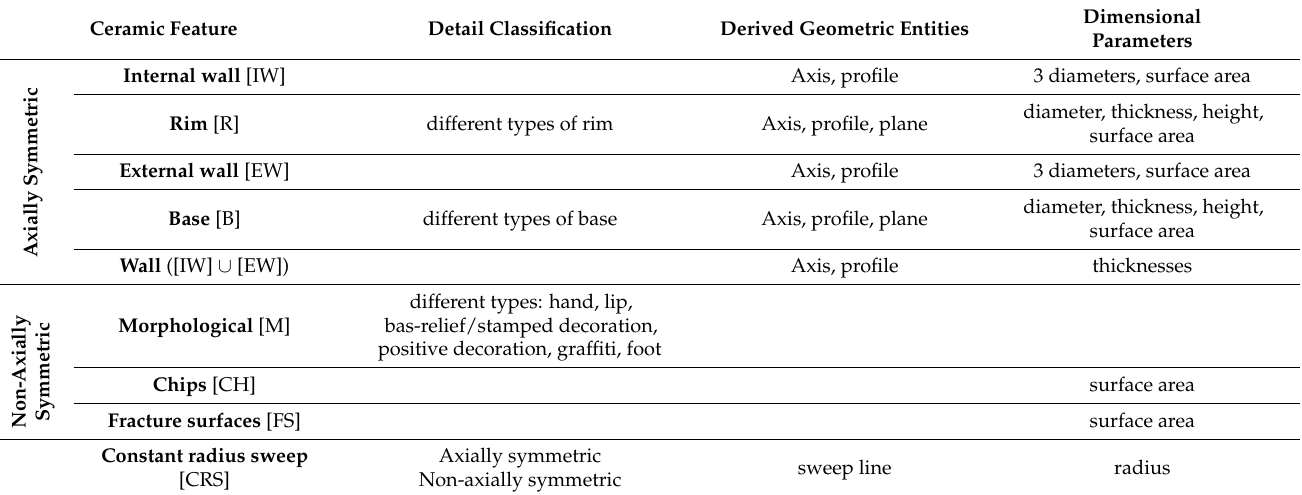
Table 2. Categories of ceramic features deriving from the sherd surface segmentation.